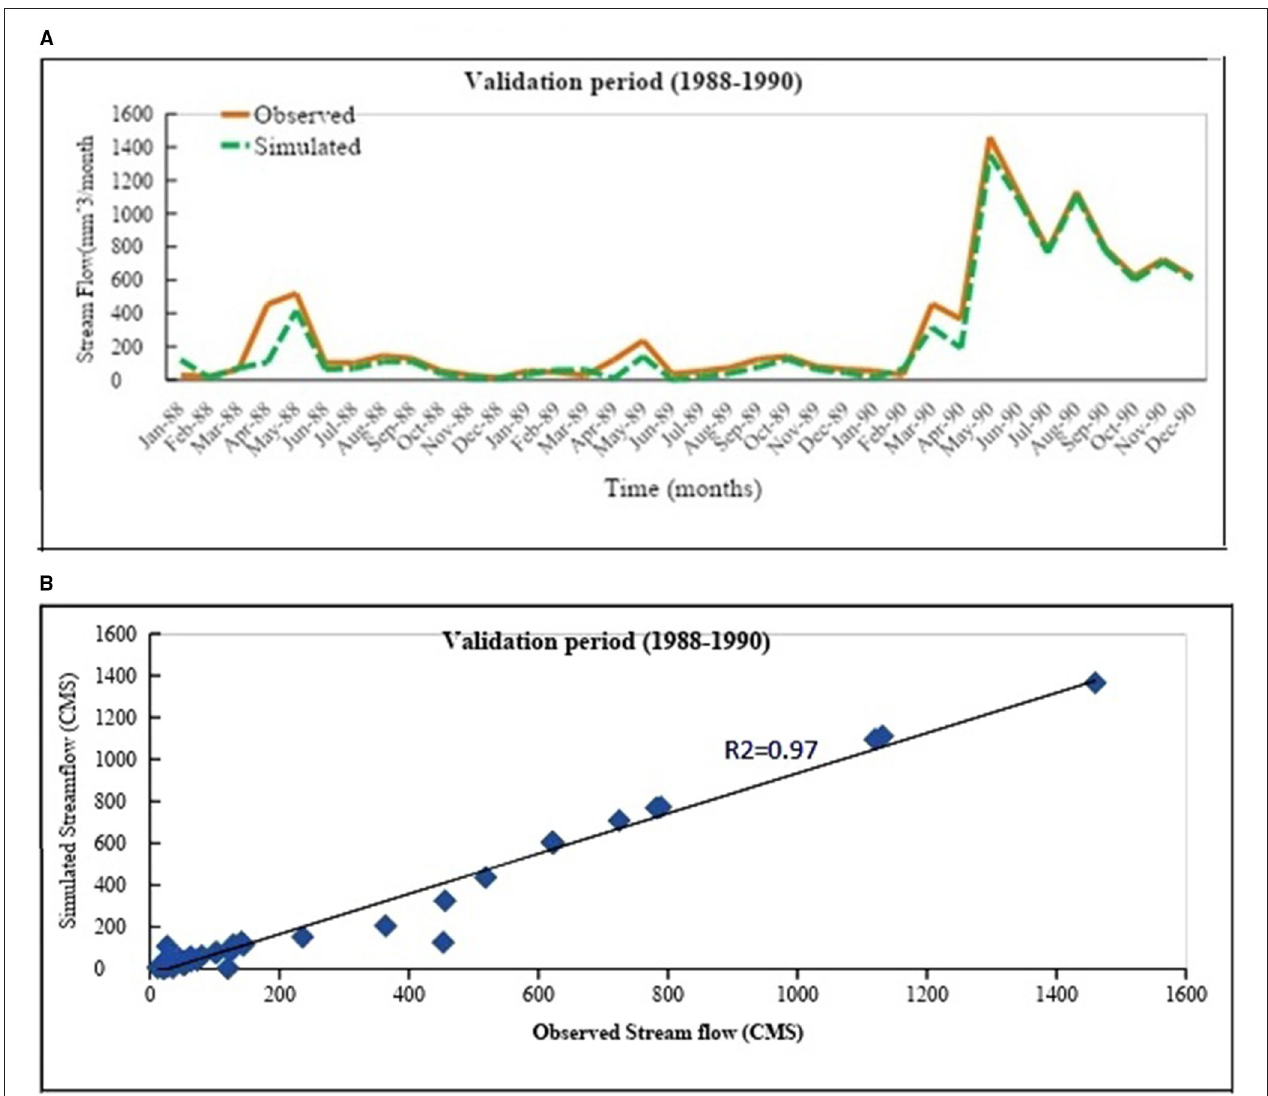
FIGURE 4 | (A) Observed and simulated stream flow during the validation period. (B) Regression line during the validation period at Ewaso Ng’iro (RGS2K01).